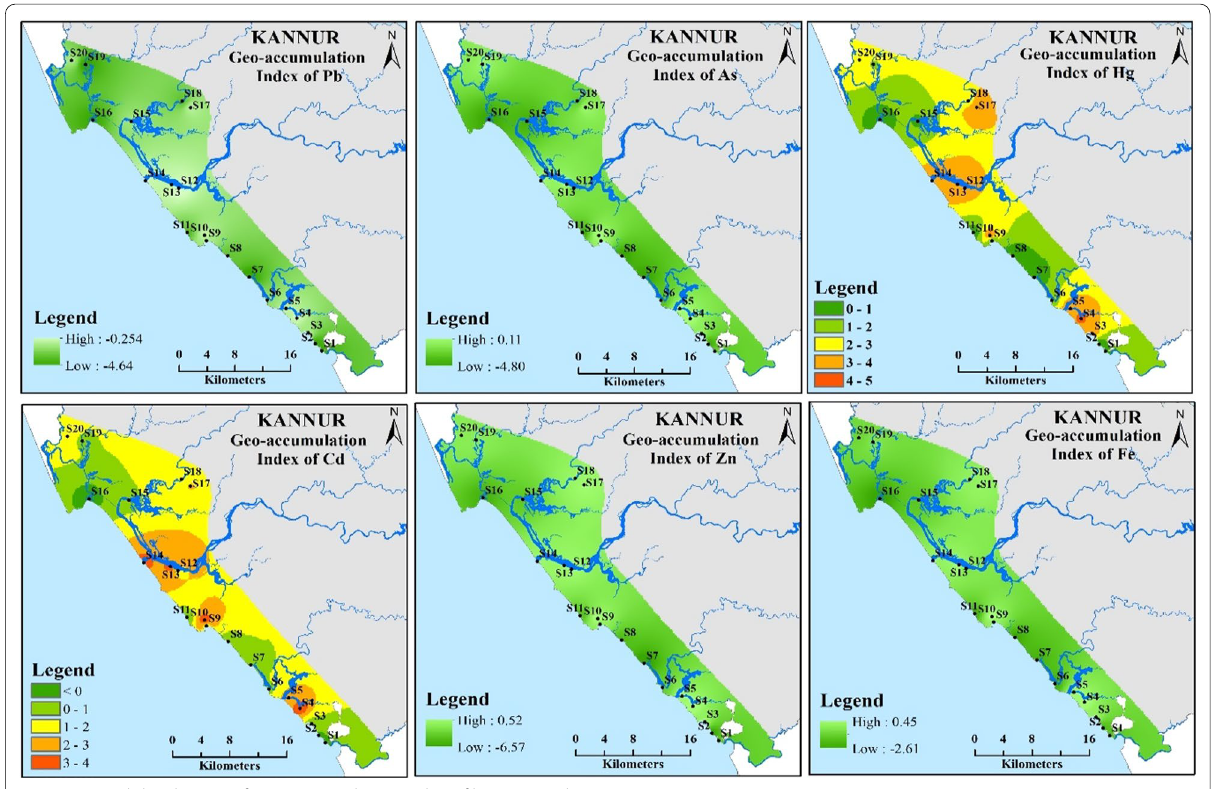
Fig. 6 Spatial distribution of geo-accumulation index of heavy metals